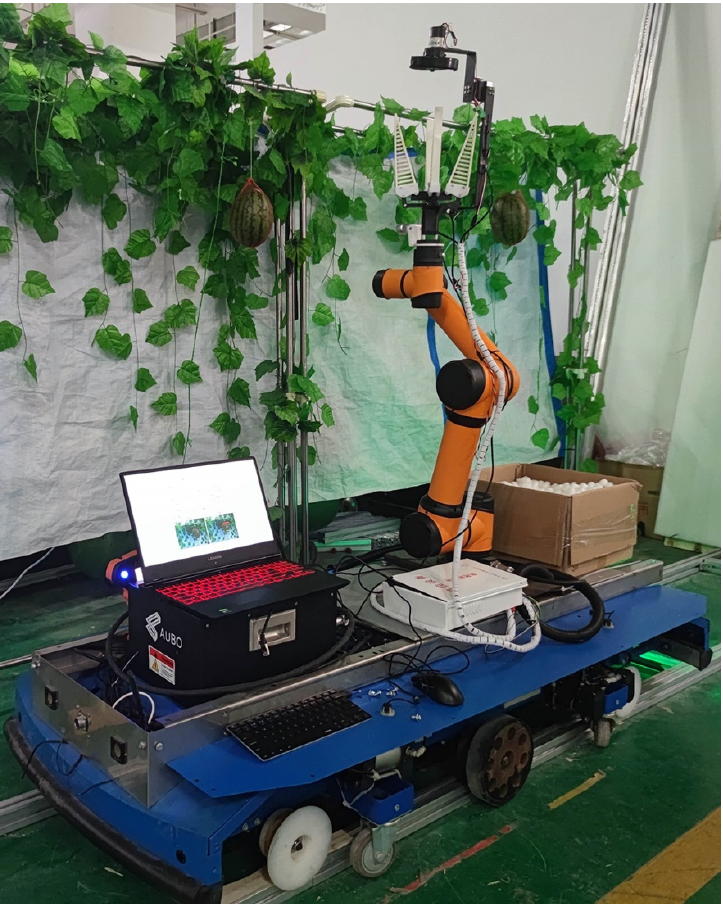
Figure 14. Validation of the watermelon-harvesting robot in a simulation environment.